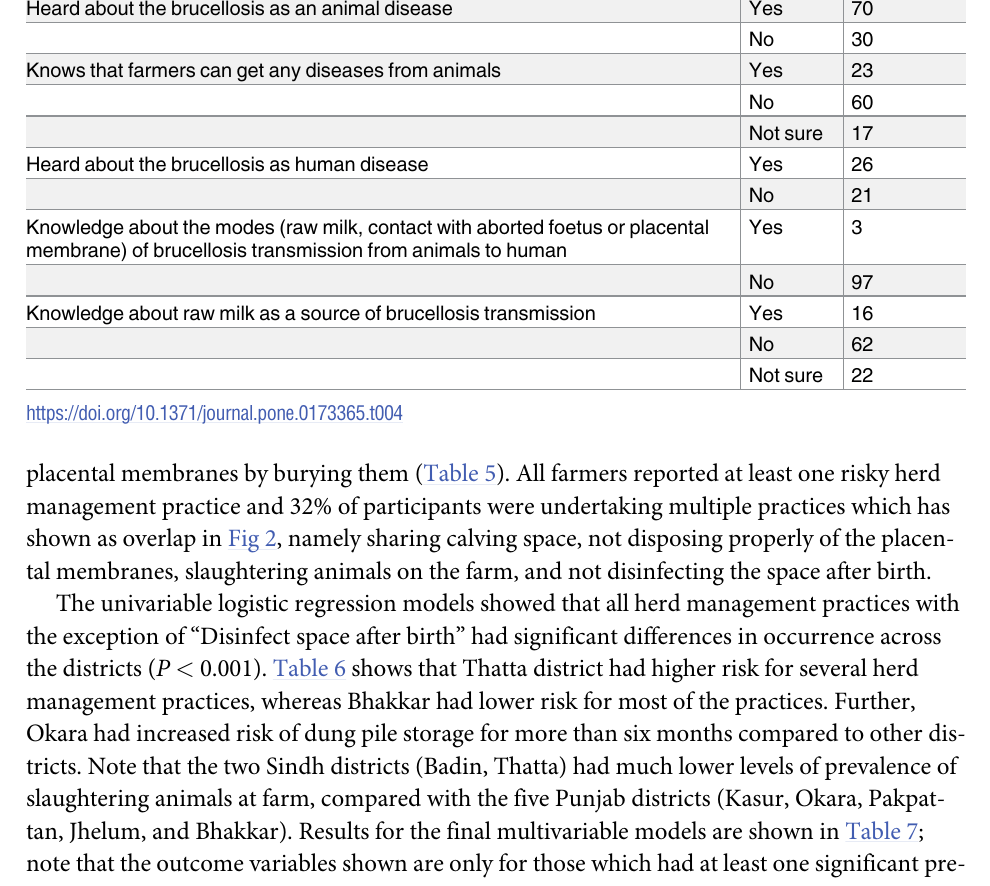
Category Percentage